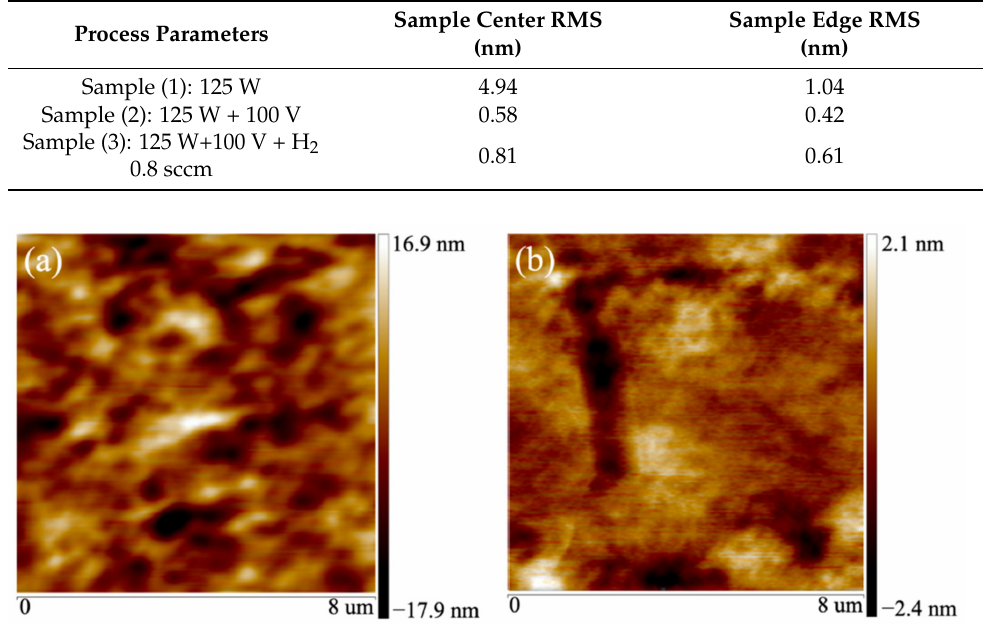
Figure 5. Surface roughness on the sample center: ( a ) Sample (1):125 W; ( b ) Sample (3):125 W + 100 V + H 2 0.8